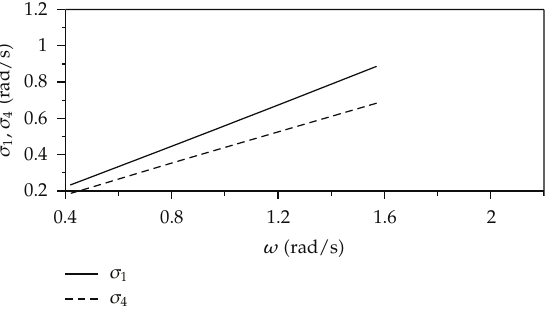
Figure 4: Two internal wave frequencies as functions of surface wave frequency ω , H (cid:8) 4m, γ (cid:4) (cid:8) γ (cid:4)(cid:4) (cid:8) 0 . 83, and h (cid:8) 0 .